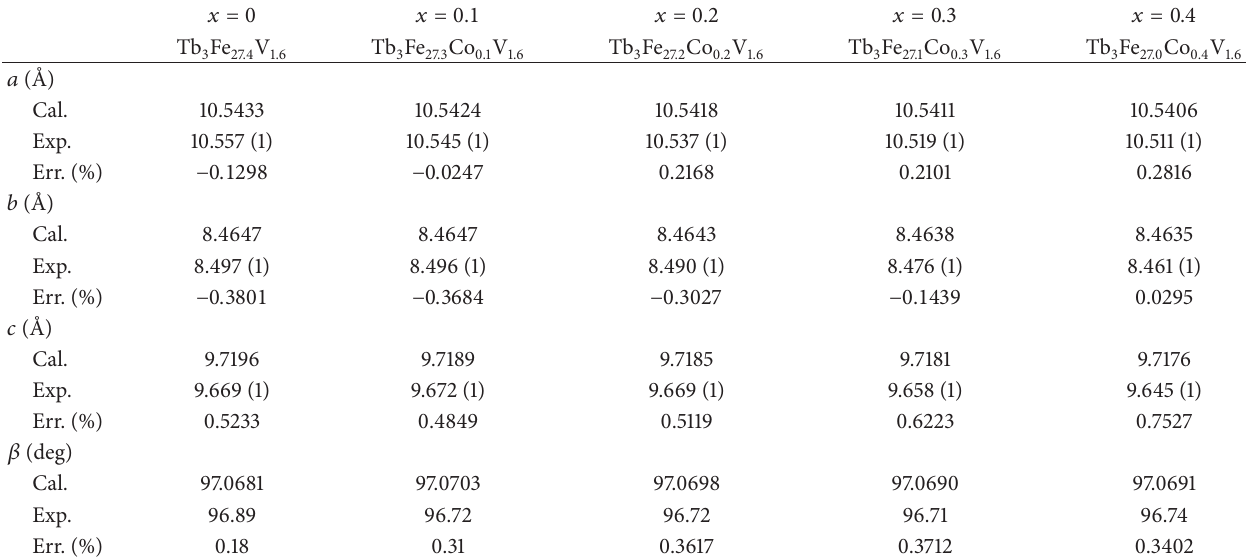
Table 2: Comparison of calculated and experimental unit cell parameters.